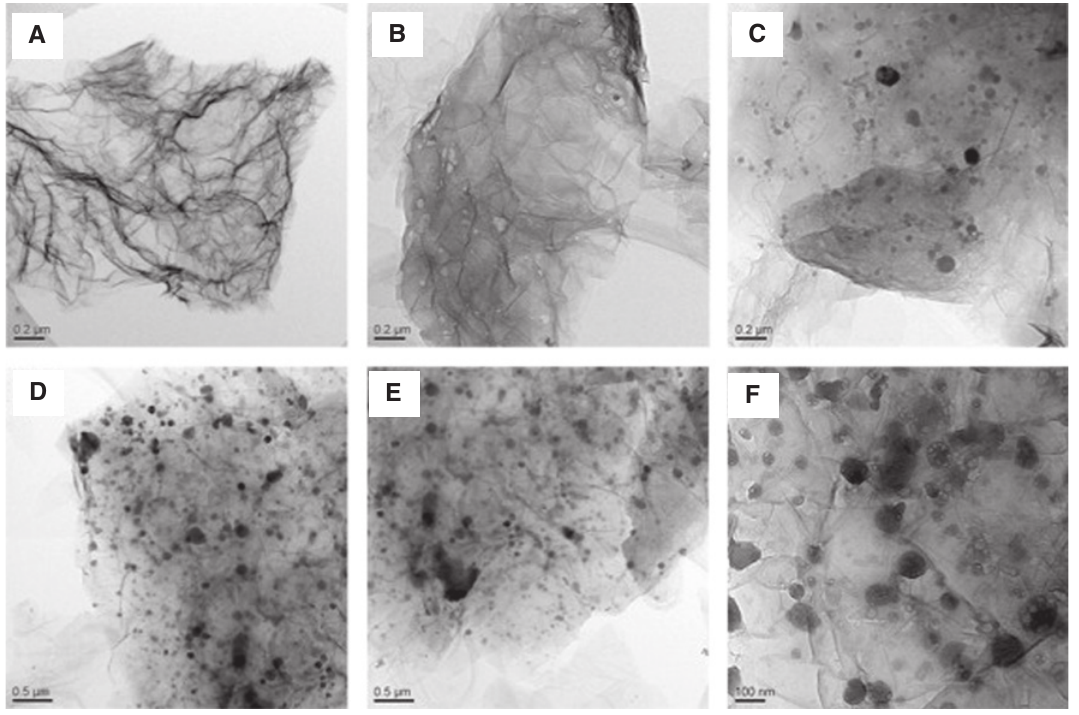
Figure 5: TEM images of (A) pristine TRG sheet, (B) TRG0 sheet, (C) TRG10 sheet, and (D–F) TRG30 sheet extracted from various PCG compos- ite supernatant [45].